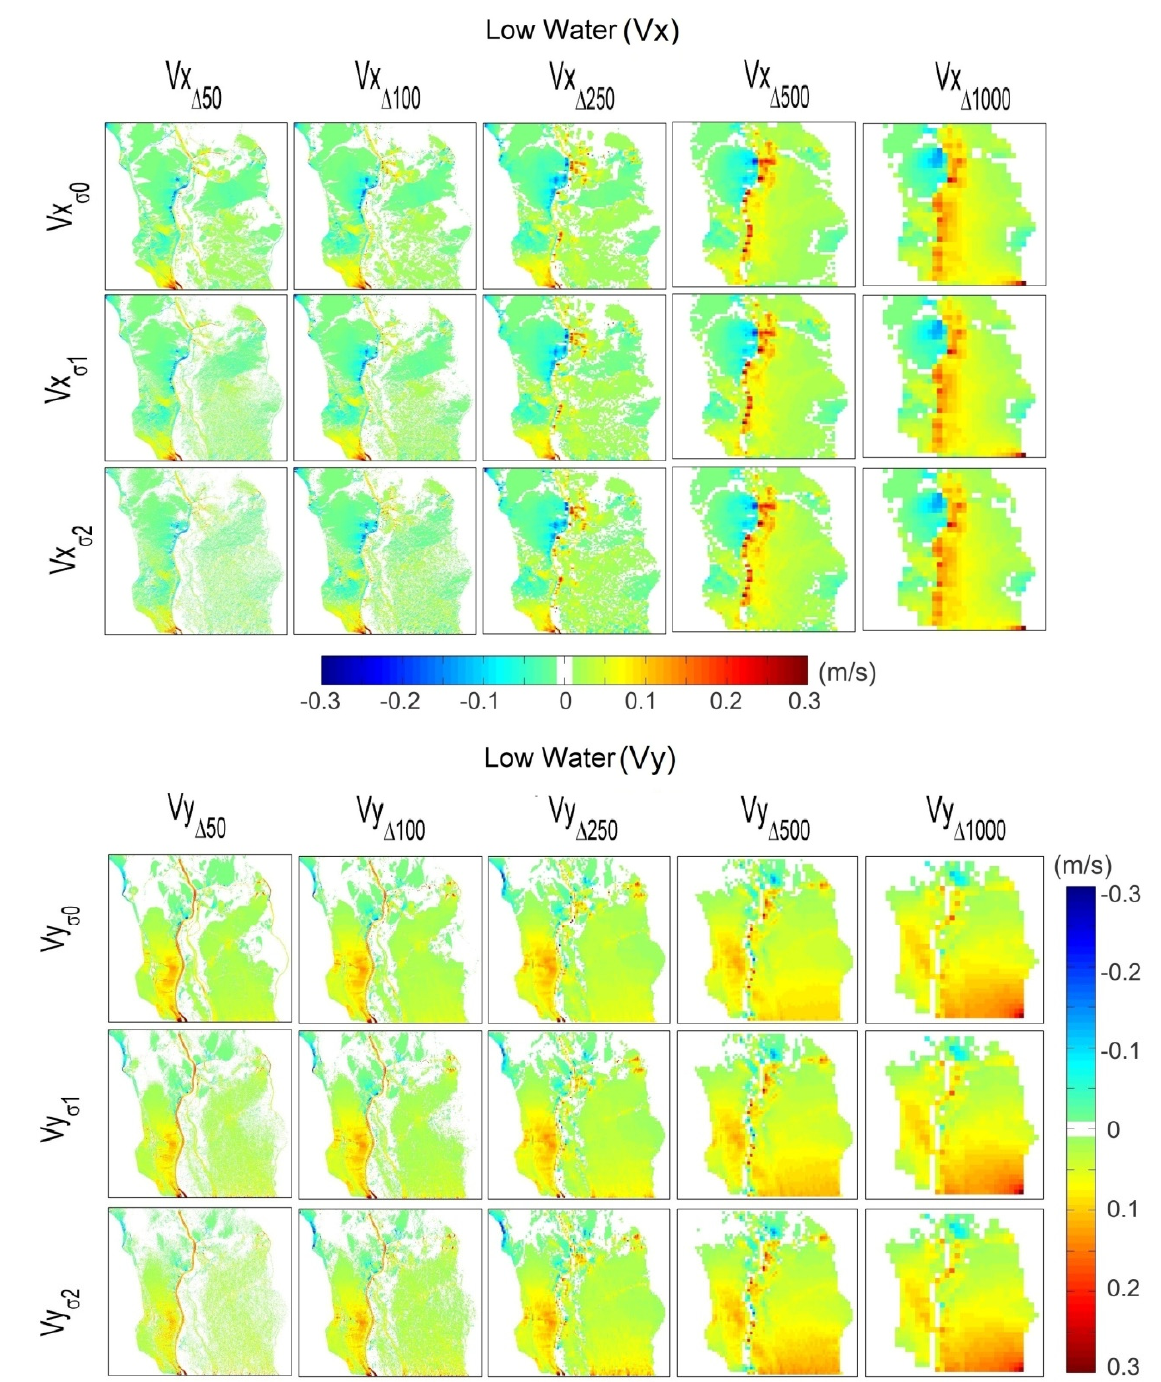
Figure 6. Water velocity maps in the direction of perpendicular (Vx) and parallel (Vy) to the main stem flow path on high water (day 28) and low water (day 62). Profiles c1-c2 and d1-d2 are used to calculate the Vx and Vy RMSEs, respectively, in Figure 7. The trade-off between DEM vertical error and grid-box size, in terms of modeled velocities, is shown in Figure 7. Results are similar to Figure 5 for water elevation. As grid-box size increases, the impact ranges up to ~0.06 m/s in RMSE for both directions on both high and low waters. Overall, little impact is observed of DEM vertical error at coarser grid-box sizes 500 m and 1000 m. On high water at finer grid-box sizes 50 m and 100 m, the impact is greater than on low water. In Figure 7c,